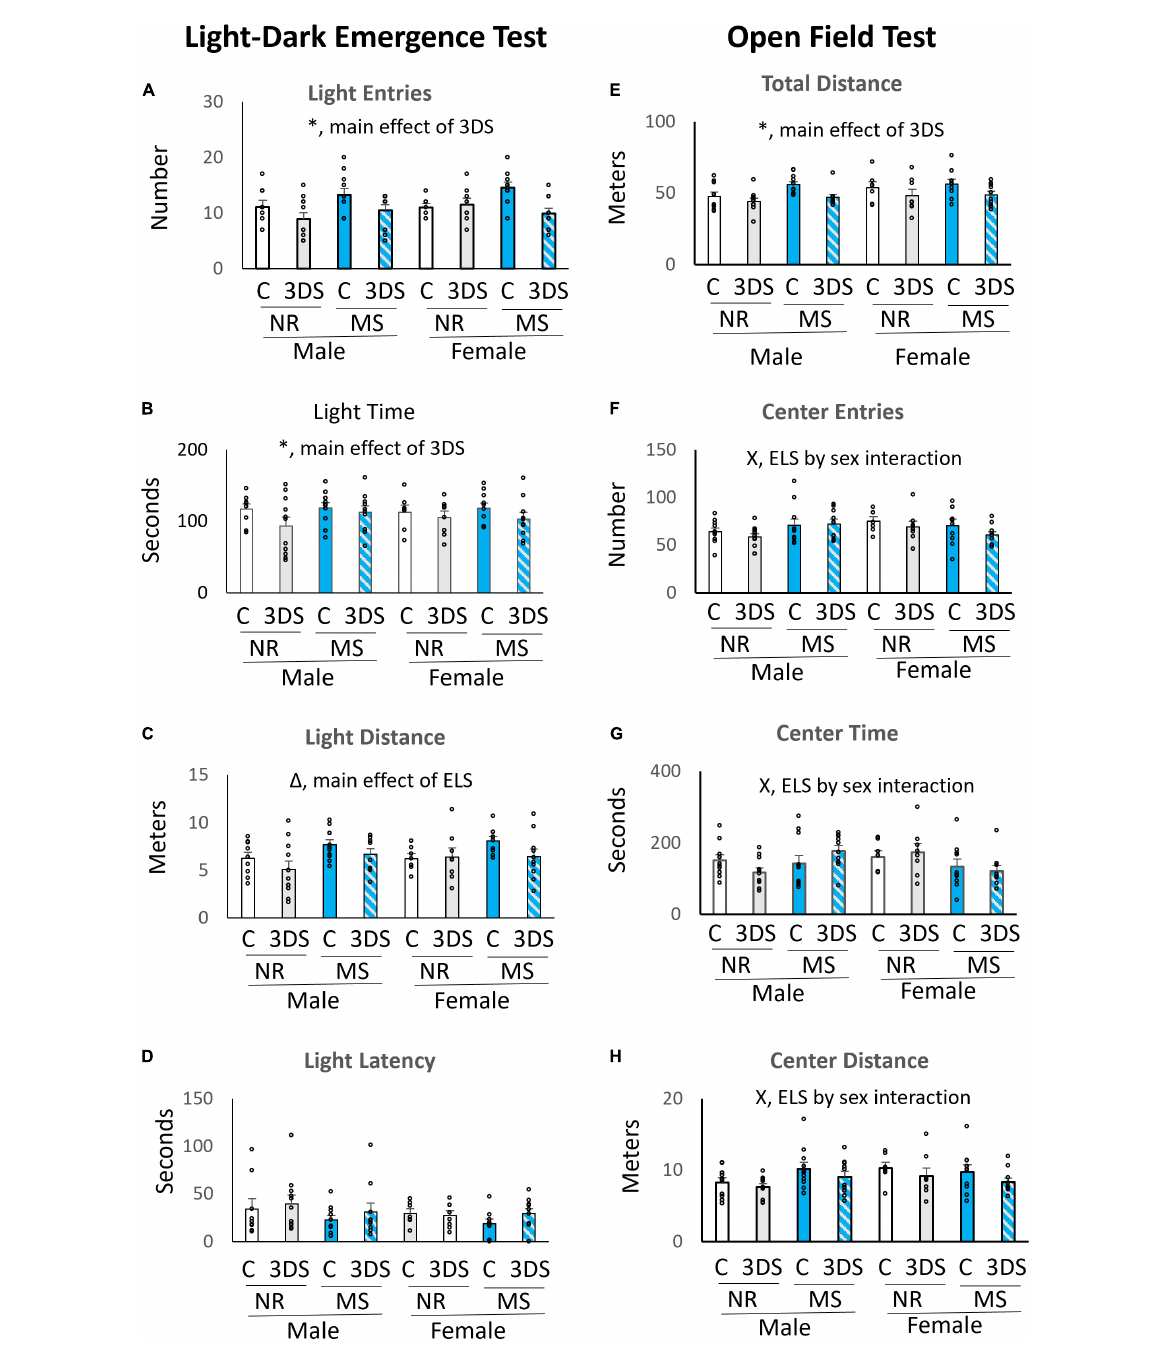
FIGURE2 The effects of maternal separation and 3 days of variable stress on behavior in the light-dark emergence test and open field test. For the light-dark emergence test the average number of entries into the light chamber (A) , time spent in the light chamber (B) , distance traveled in the light chamber (C) , and latency until the first entry into the light chamber (D) are plotted. For the open field test the average total distance traveled (E) , number of entries into the center (F) , time spent in the center (G) , and distance traveled in the center (H) are plotted. Error bars reflect the standard error of the mean. Each individual data point is shown. NR, stands for normal rearing; MS, stands for maternal separation; C, stands for control; and 3DS stands for 3 days of stress exposure. For the open field test, N = 10 for male NR control, 11 for male NR 3DS, 11 for male MS control, 10 for male MS 3DS, 7 for female NR control, 8 for female NR 3DS, 10 for female MS control, and 10 for female MS 3DS. In the light-dark emergence test, one outlier was excluded from the Male NR control group leaving a sample size of N = 9. All other group sizes were identical. ∗ Denotes a main effect of adult stress, (cid:49) denotes a main effect of early life stress, and X denotes an early life stress by sex interaction by three-way